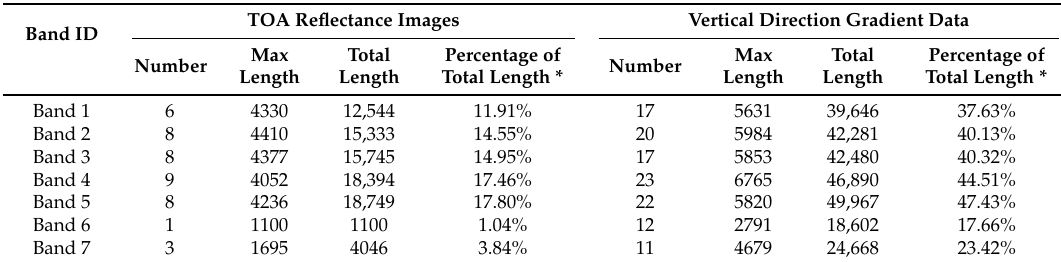
Table 7. Statistics of detected tidal cracks with lengths greater than 1000 m from the TOA reflectance images and vertical direction gradient data with a resolution of 30 m.